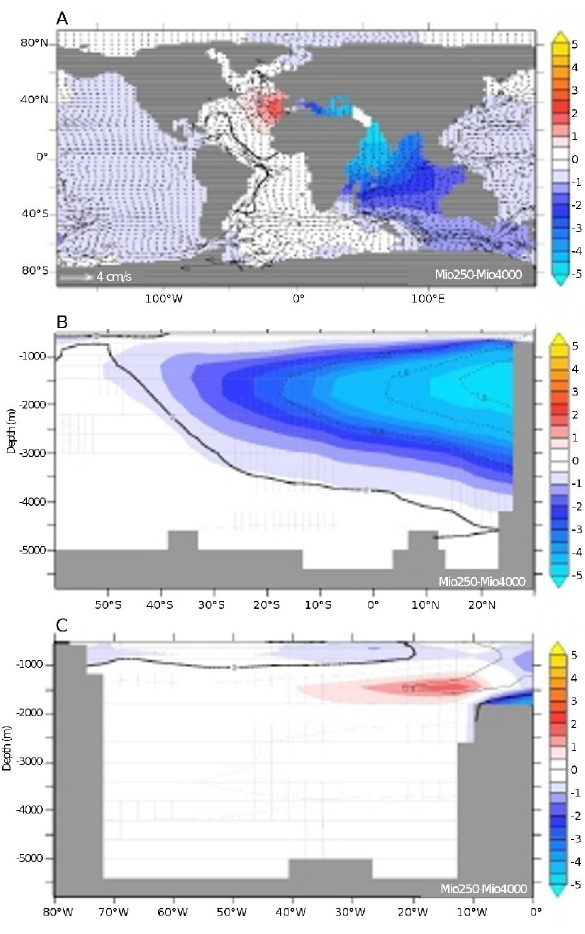
Fig. 8. (A) Simulated temperature difference at 952m between Mio250 and Mio4000 experiments. Vectors indicate Mio4000 hor- izontal flow. (B) Mio250–MioC anomaly of temperature (shaded colours, ◦ C) and salinity (isolines, psu) as a function of depth, av- eraged between 45 ◦ E and 60 ◦ E. (C) Mio250–MioC anomaly of temperature (shaded colours, ◦ C) and salinity (isolines, psu) as a function of depth, averaged between 30 ◦ N and 40 ◦ N.